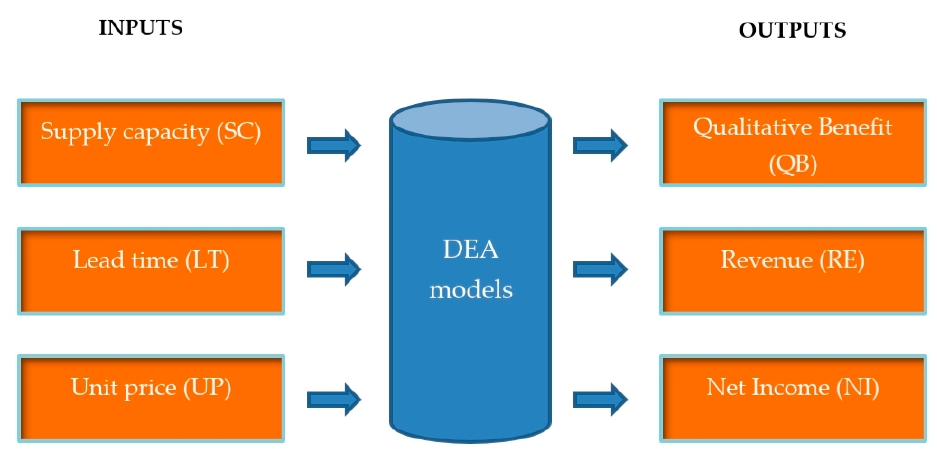
Figure 2. Inputs and outputs of the DEA model.